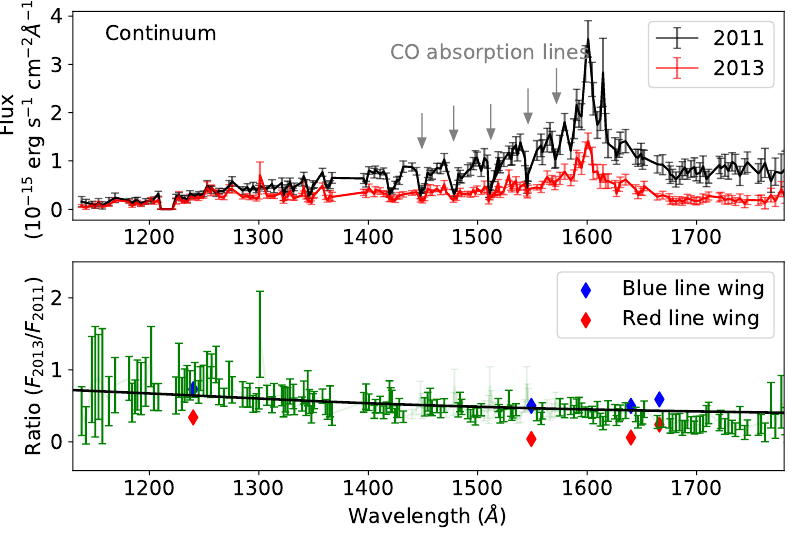
Figure 12. Top : FUV continuum spectra of AA Tau during bright and dim states. Bottom : Ratio between bright and dim states with the evolution of emission lines shown in blue/red diamonds for the blue and red line wing, respectively. Notable is the bluer appearance of the continuum during the dim state, which is incompatible with just extra absorption and more compatible with scattering. From Schneider et al.